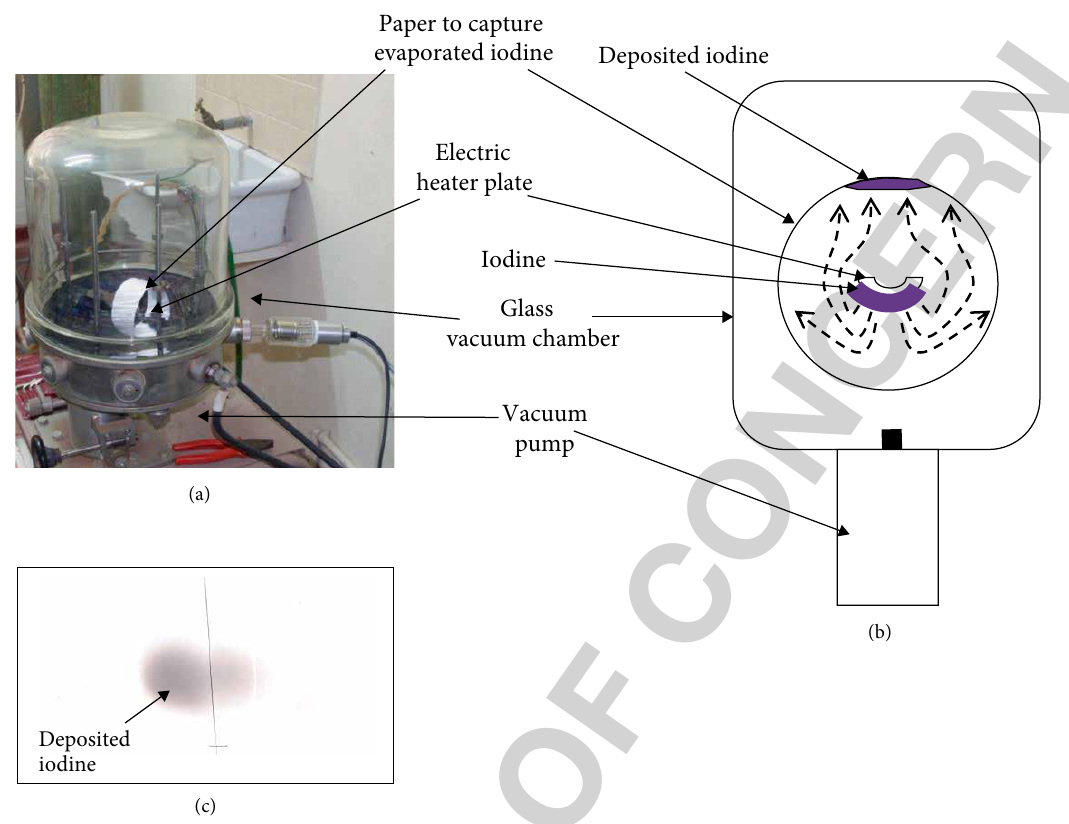
Figure 1: Figure extracted from reference [2]—Experimental set-up to observe movement of heat-evaporated iodine vapor in vacuum. (a) Vacuum deposition chamber. (b) A layer of iodine was gradually heat evaporated (ejected downward direction) inside the vacuum chamber. The electrical heater plate itself covers the iodine particles moving directly in upward direction. The iodine source was surrounded with a paper jacket in order to capture the deposition geometry of iodine. The paper was placed 50 mm radially away from the iodine source. Pressure in the chamber was ~1 × 10 −5 mbar, average mean free path is greater than 6.6 m, and air density was approximately 12.6 ng m −3 . Pressure at the top (𝑃 top ) of the chamber was higher than at the bottom (𝑃 bottom ) , 𝑃 top > 𝑃 bottom . (c) Photograph of deposited iodine on the inner top part of the paper. Reprinted from “Antigravity—Is it already under our nose?” by C. K. G. Piyadasa, 2011, Canadian Journal of Pure and Applied Sciences, Vol. 5, No. 2, pp. 1586, Reprinted by permission of SENRA Academic Publishers, 5919 129